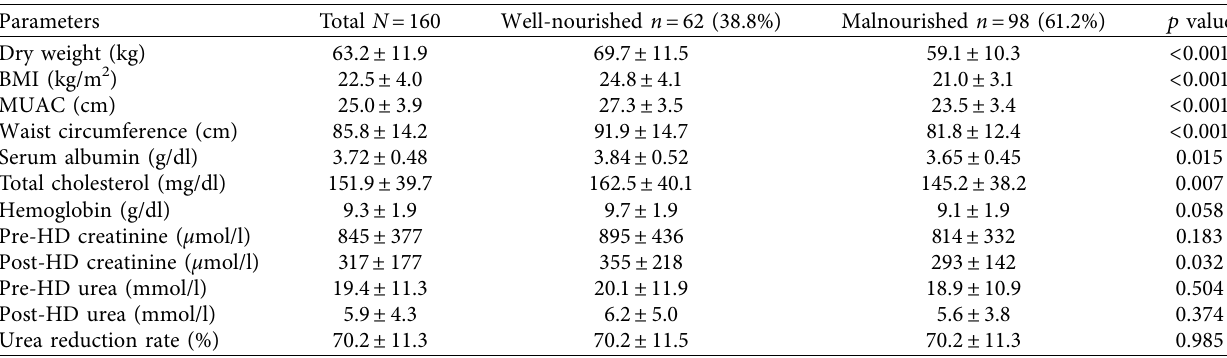
Table 2: Comparison of anthropometric and biochemical parameters with nutritional status of hemodialysis patients. N � 160.